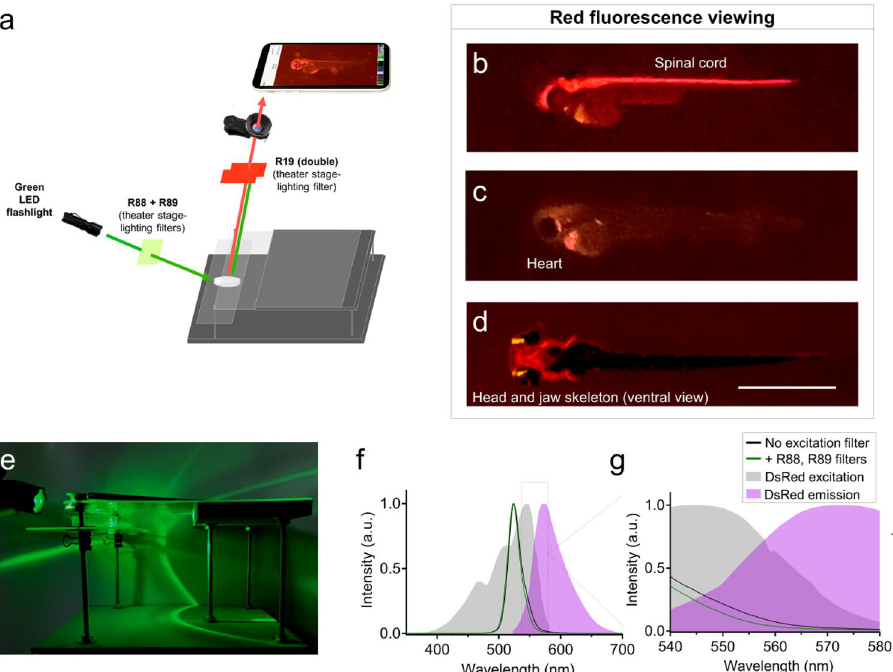
Figure 3. Glowscope detection of red fluorescent proteins. ( a ) Schematic of components used for red fluorescence viewing on the glowscope. In comparison to green fluorescence viewing, flashlight and filters are changed, but the remainder of the glowscope is unchanged. ( b–d ) Representative fluorescence images of transgenic zebrafish embryos (3–4 dpf, lateral views) expressing red fluorescence in cell-type specific patterns. Reporter lines viewed include Tg(olig2:DsRed) ( b ), Tg(myl7:mCherry) ( c ), and Tg(sox10:mRFP) ( d ). Scale bar is 1 mm. ( e ) Image shows the glowscope in use for red fluorescence viewing. ( f–g ) Plots show the green LED flashlight emission wavelength (black and green lines, measured using a Vernier spectrometer) in comparison to the excitation profile of DsRed (gray, obtained from www. fpbase. org). The dashed box region in panel ( f) is further magnified in panel ( g ) to show the effect of the R88 + R89 filters with greater detail. Images in panels ( b–c ) were acquired using an Apple iPhone XR and panel ( d ) was acquired using an iPhone 12